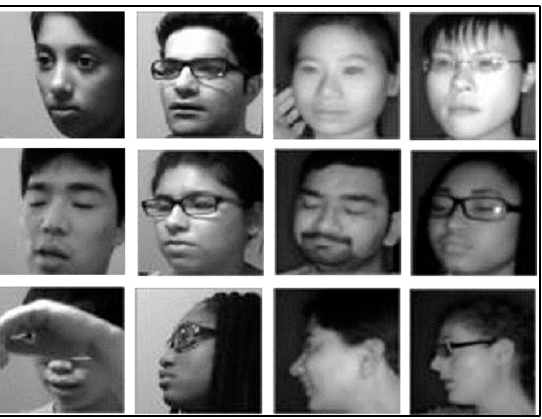
Figure 10. Some examples of face regions in database. Top: “eyes open” class; middle: “eyes close”; and bottom: “distraction”.